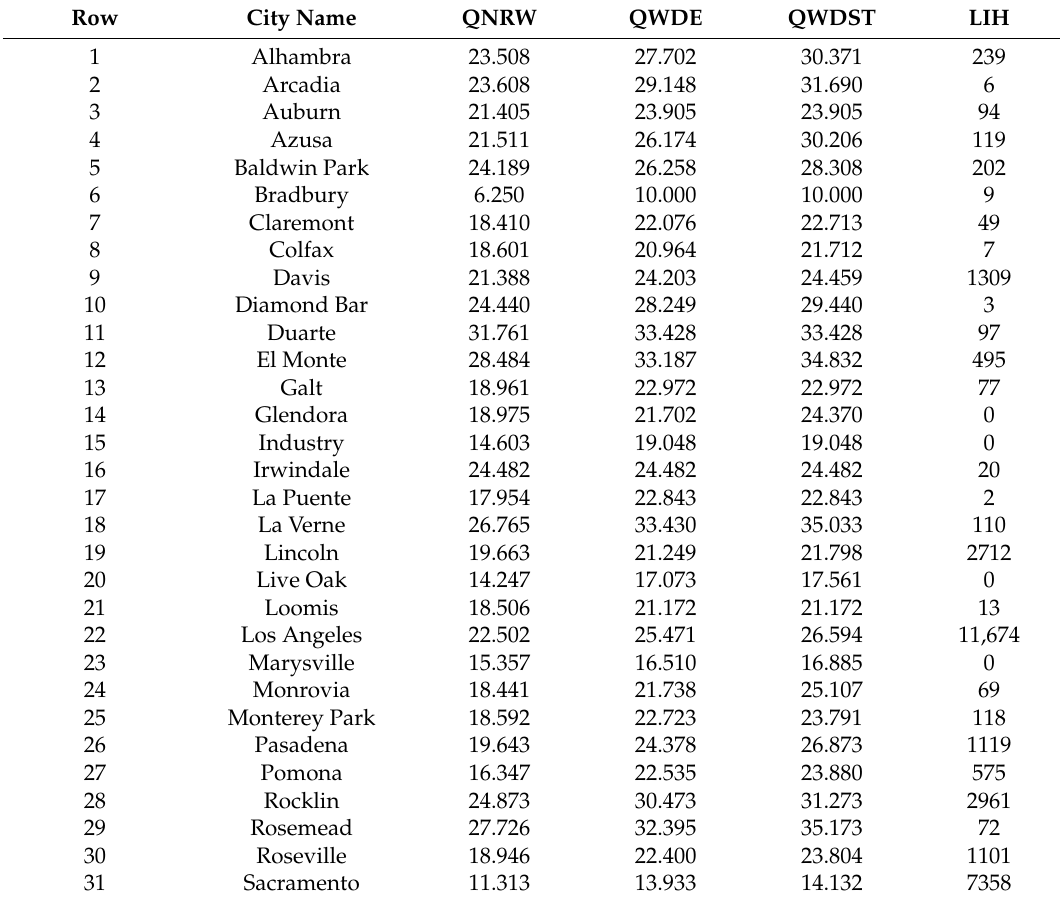
Table A4. Sample (Alphabetized). This table identifies the three quality scores and low-income housing production for each